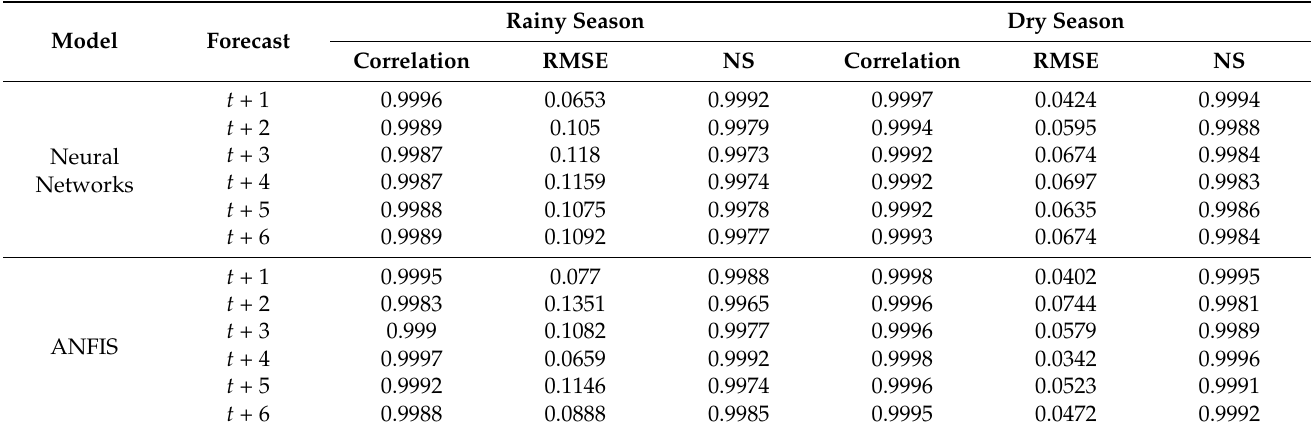
Table 3. Performance parameters of NN and ANFIS models in seasonality.